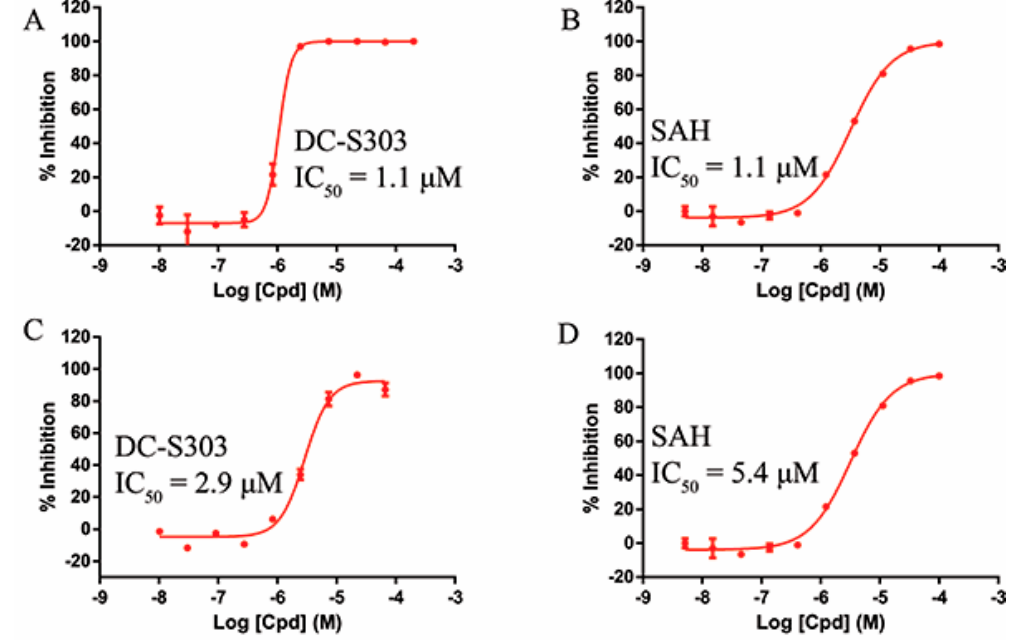
Figure 5. Enzymatic activity of DC-S303 against SET7. ( A ) IC 50 value of DC-S303 in AlphaLisa assay; ( B ) IC 50 value of the reference compound SAH in AlphaLisa assay; ( C ) IC 50 value of DC-S303 in radioactive assay; ( D ) IC 50 value of the reference compound SAH in radioactive assay.